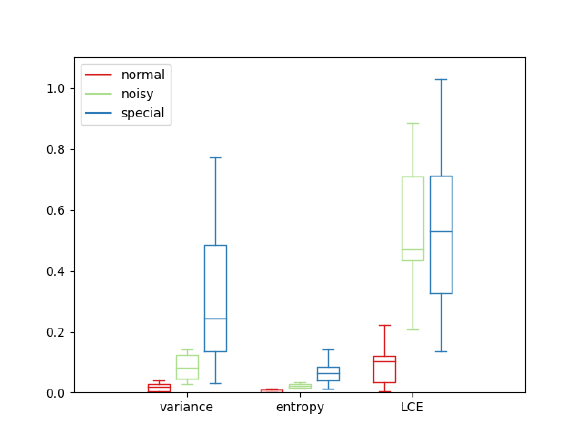
Figure 5. Examples of noisy ad out-of-distribution data. Noisy examples include scanning artifacts (a), noisy strokes (b) and painting errors (c). (d) (e) (f) show examples of different designs for lakes of Siegfried maps (25k), Siegfried maps (50k), and old national maps (25k), respectively.